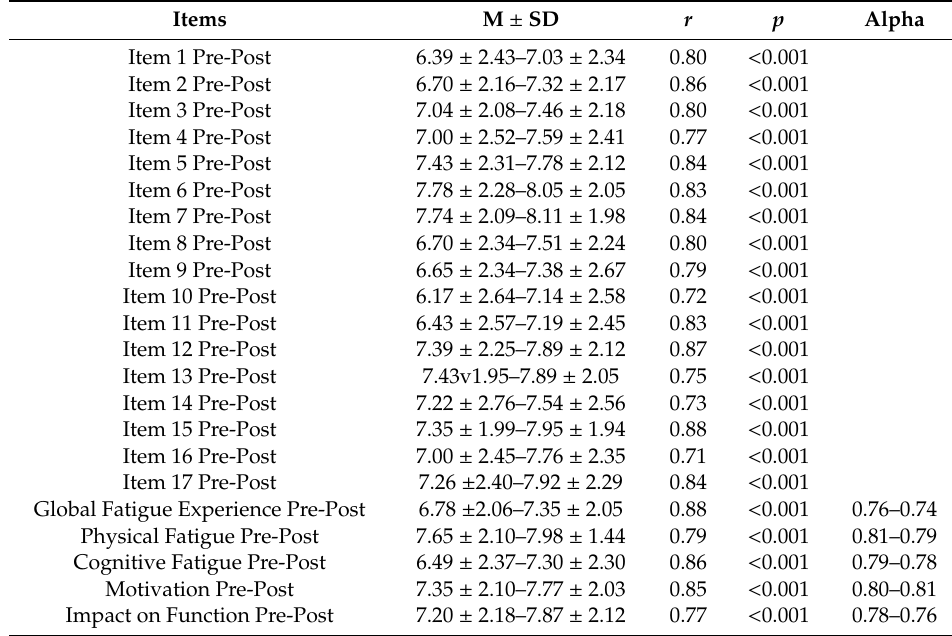
Table 2. Test-retest reliability analysis (Brazilian sub-sample = 40).